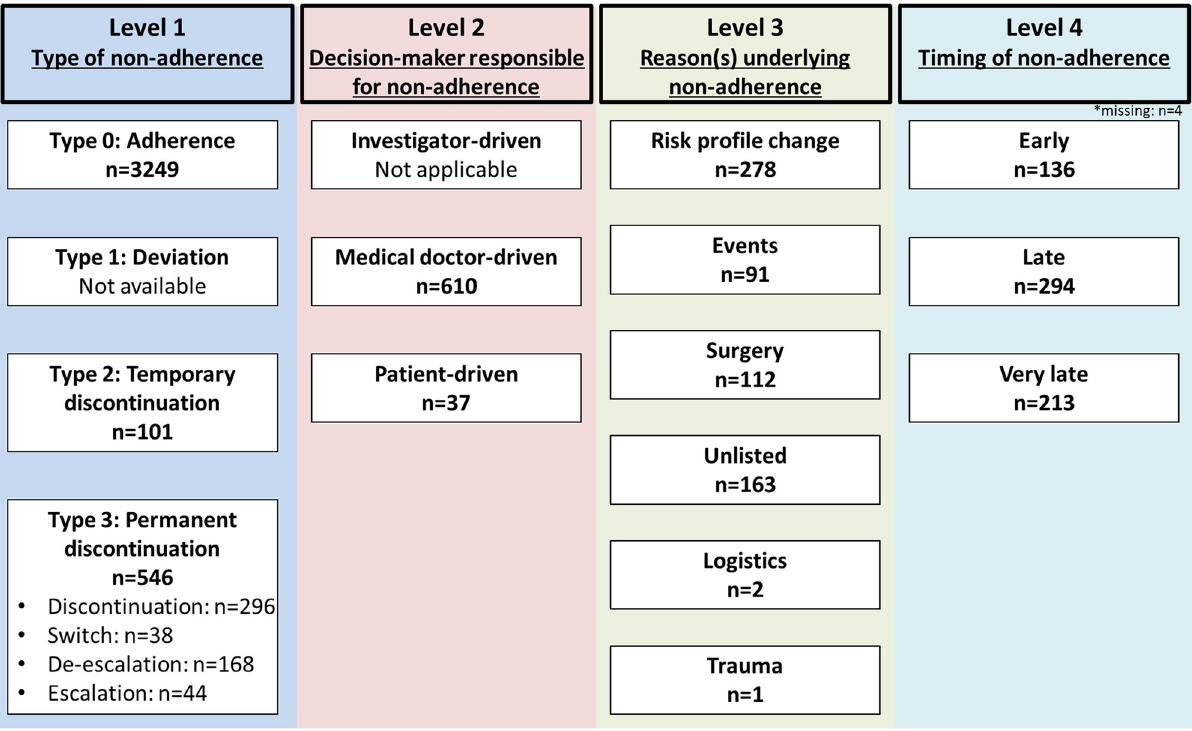
Fig 2. Overview of non-adherence according to NARC classification. NARC = non-adherence academic research consortium.